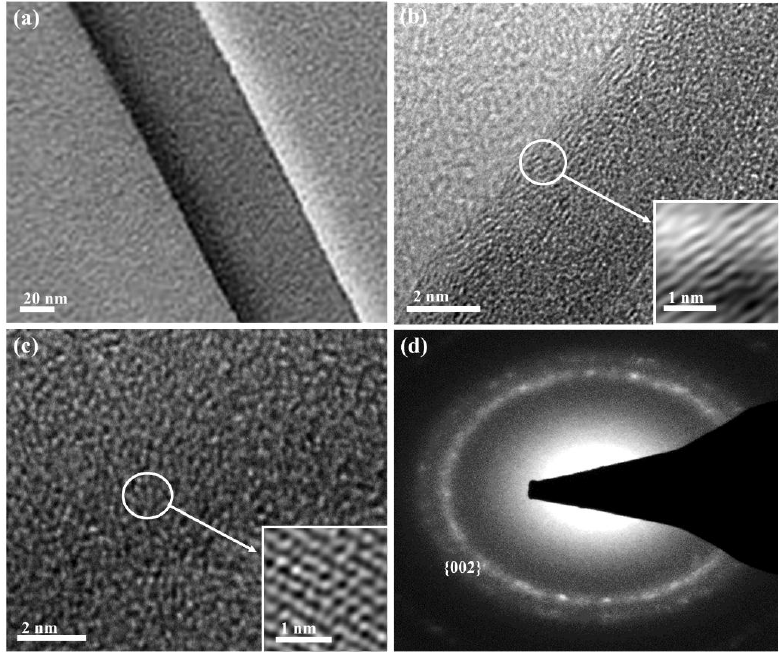
Figure 2. ( a ) High magnification TEM image of Pd/Cu/gCN NWs; ( b , c ) HRTEM images; and ( d ) SAED pattern of Pd/Cu/CN NWs. The insights show the corresponding Fourier filtered images for the marked areas in ( b , c ), respectively.